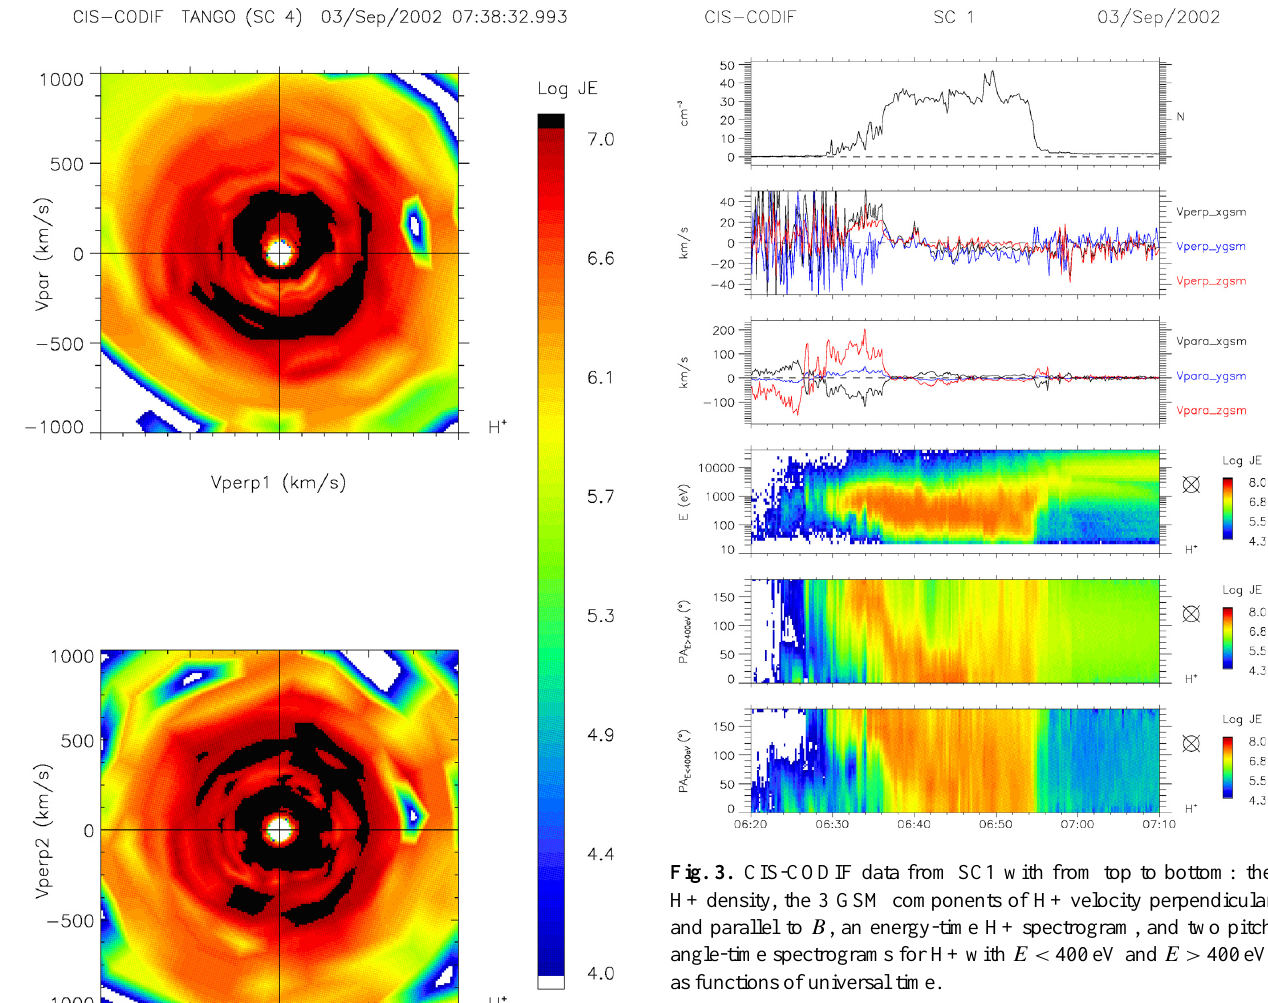
itive V x confirms that these open field lines convect